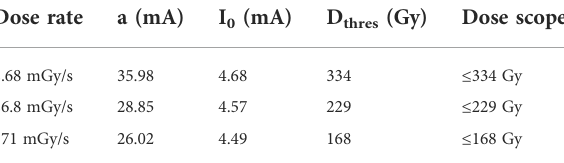
TABLE 6 The values of parameter at different dose rate.